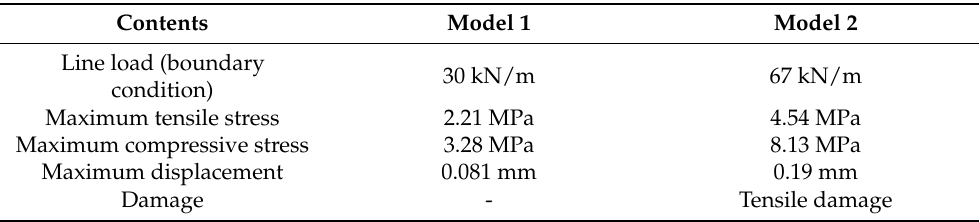
Table 6. Results of finite element analysis for complex cross-section concrete pipe.